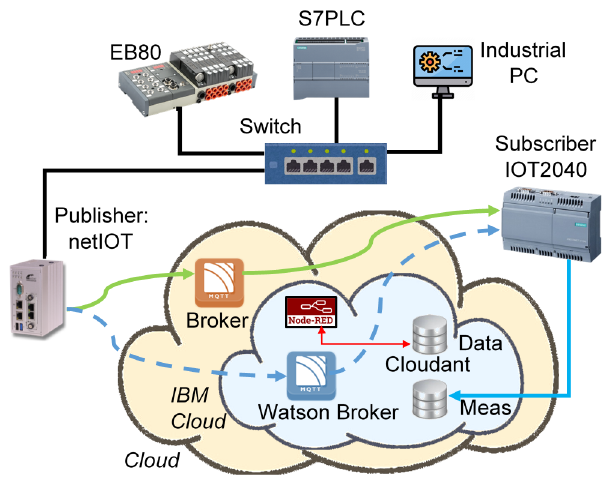
Figure 3. The experimental setup for the considered use case. The database access and the cloud application are the same for both the considered Brokers.